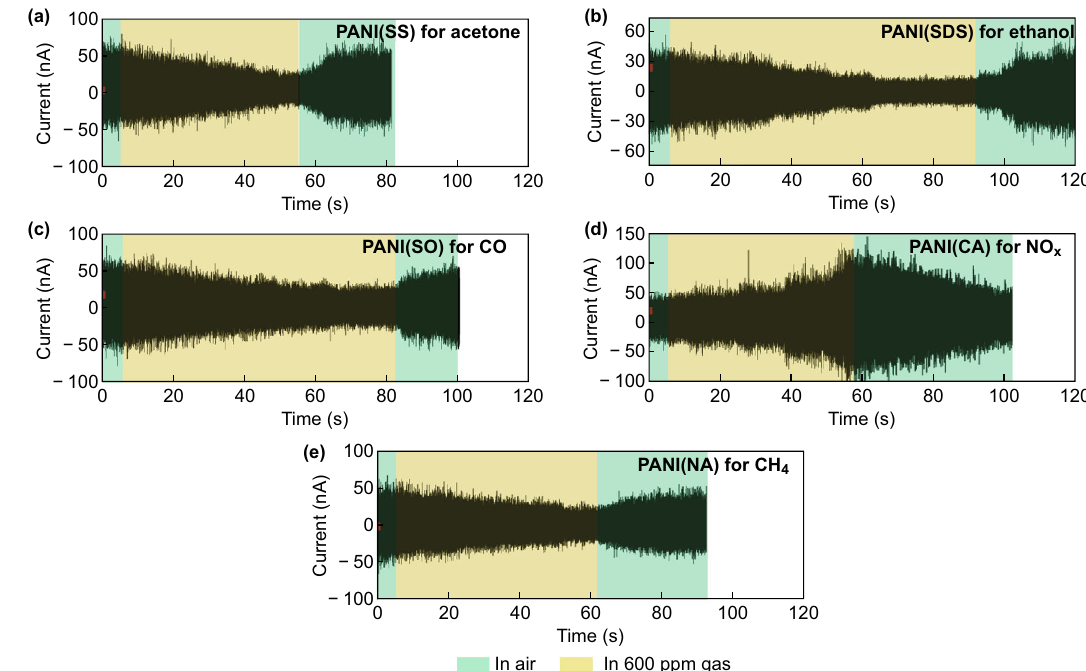
Fig. 5 Response/recovery processes of the sensing units. a PANI(SS) for acetone. b PANI(SDS) for ethanol. c PANI(SO) for CO. d PANI(CA) for NO x . e PANI(NA) for CH 4